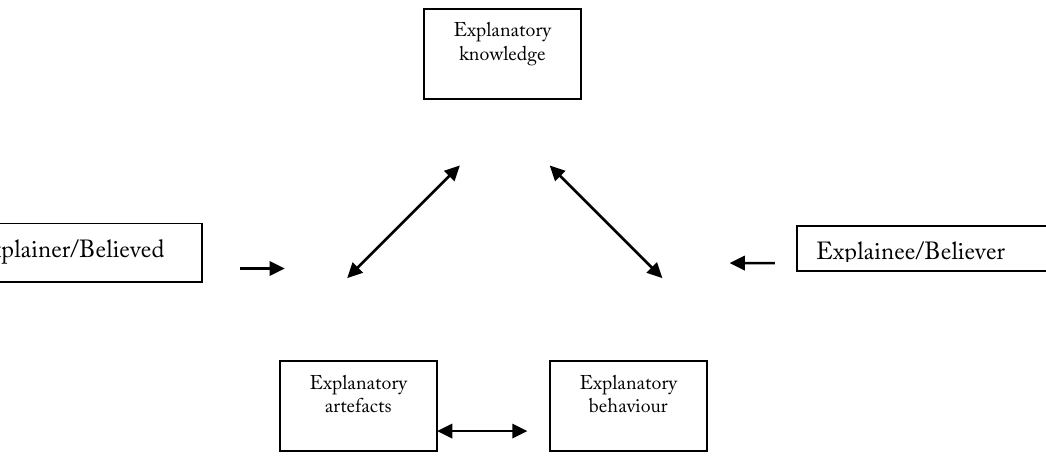
Figure 1: Components of an